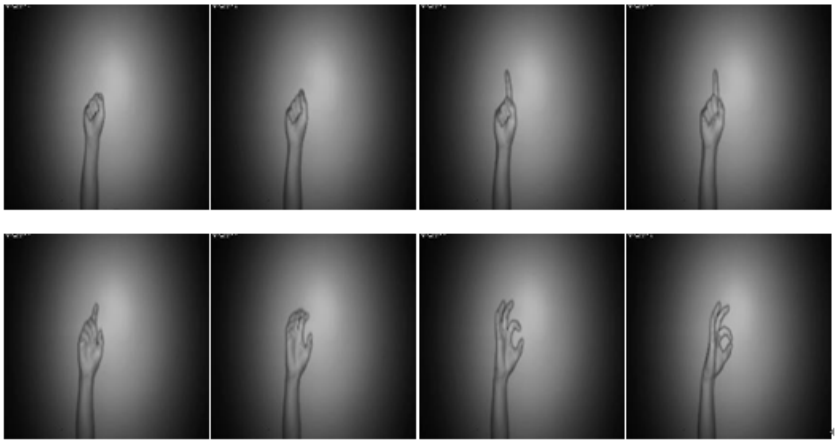
Figure 15. The sensor modality of “CCD RGB-IR” of the hand gesture intention action, Action 1.